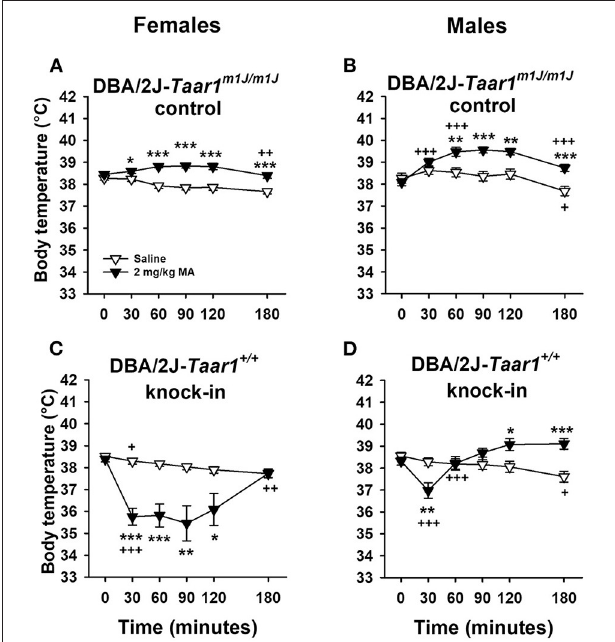
FIGURE 7 | DBA/2J -Taar1 + / + KI mice display MA-induced hypothermia, whereas DBA/2J- Taar1 m 1 J / m 1 J control mice exhibit MA-induced hyperthermia. Shown are means ± SEM for core body temperature ( ◦ C) for female (A) and male (B) DBA/2J- Taar1 m 1 J / m 1 J control mice, and for female (C) and male (D) DBA/2J -Taar1 + / + KI mice. Data are shown separately for the sexes due to a significant line × sex × treatment interaction. A baseline temperature was obtained (T0), mice were treated IP with saline or 2 mg/kg MA, and then rectal temperatures were obtained periodically from T30 to T180. Total N = 81 mice (11 female saline and 10 female MA-treated DBA/2J- Taar1 m 1 J / m 1 J control; 10 female DBA/2J -Taar1 + / + KI per treatment; 10 male per mouse line and treatment). * p < 0.05, ** p < 0.01, *** p < 0.001 for the effect of treatment; + p < 0.05, ++ p < 0.01, +++ p < 0.001 for the change in body temperature from the previous temperature. MA, methamphetamine; Taar1 + / + , homozygous reference trace amine-associated receptor 1 genotype; Taar1 m 1 J / m 1 J , homozygous mutant trace amine-associated receptor 1 genotype.